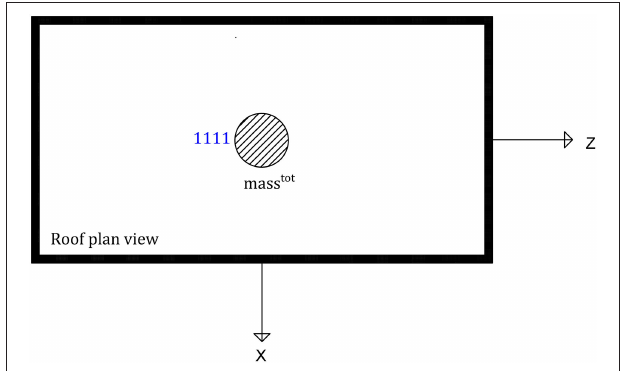
FIGURE 3 | Schematic view of the numerical model assumptions for pendulum